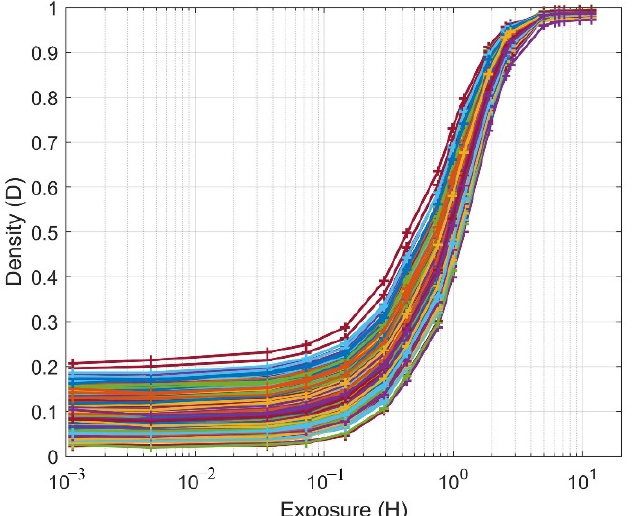
Figure 12. Measured D-log-H for all clusters, demonstrating good uniformity of threshold from 0.3 to 0.8 e −.